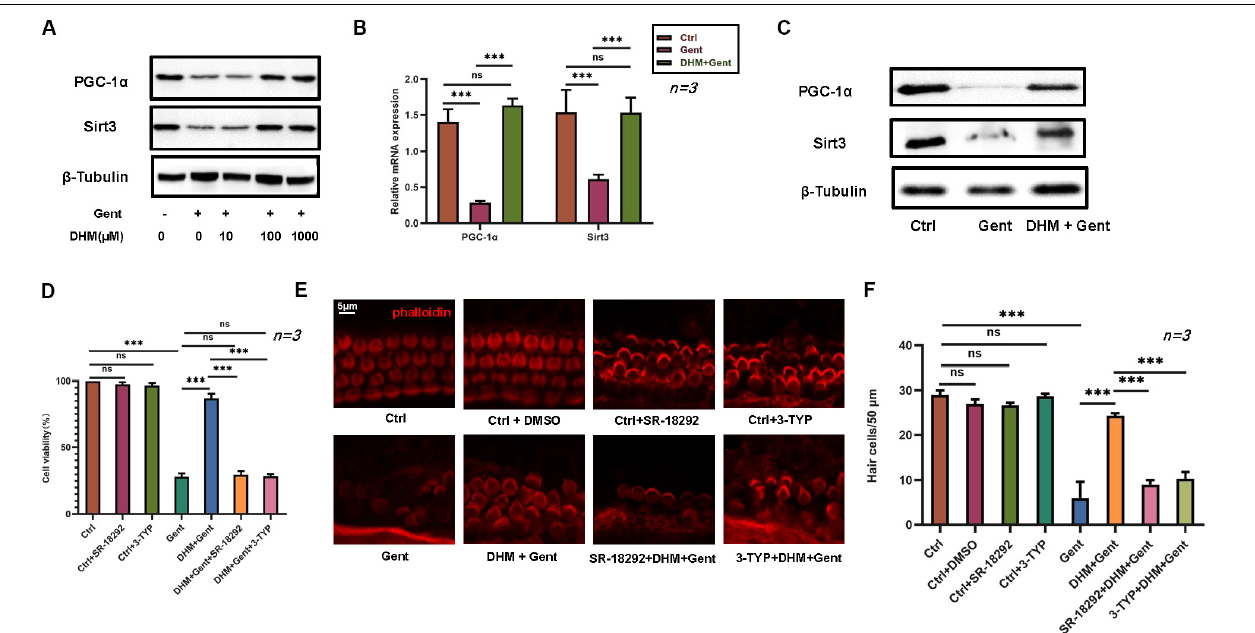
FIGURE 4 | PGC-1 α and SIRT3 mediate the protective effect of DHM against gentamicin-induced hair cell damage. (A) Endogenous PGC-1 α and SIRT3 protein expression in HEI-OC1 cells as determined by western blotting; β -tubulin was used as a loading control. (B) RT-PCR detection of PGC-1 α and SIRT3 transcript levels in cochlear explants after gentamicin treatment with or without DHM (1 mM) pretreatment; glyceraldehyde 3-phosphate dehydrogenase (GAPDH) was used as an internal control. (C) Western blot analysis of PGC-1 α and SIRT3 protein expression after DHM (1 mM) pretreatment; β -tubulin was used as a loading control. (D–F) Effect of PGC-1 α and SIRT3 inhibition (with SR-18292 and 3-TYP, respectively) on the viability of HEI-OC1 cells (D) and hair cells in cochlear explants (E,F) treated with gentamicin with or without DHM pretreatment. Experiments were repeated three times NS, not significant; ∗∗∗ P < 0.001 (one-way analysis of variance followed by Tukey’s multiple comparisons